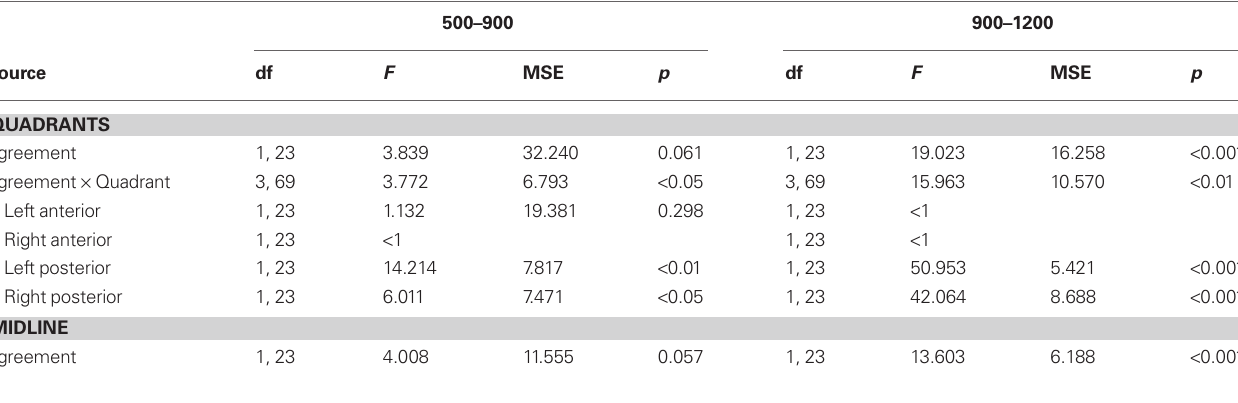
Table 3 | Analysis of variance for the mean ERP amplitudes for the agreement manipulation in the 500–900 and 900–1200 time